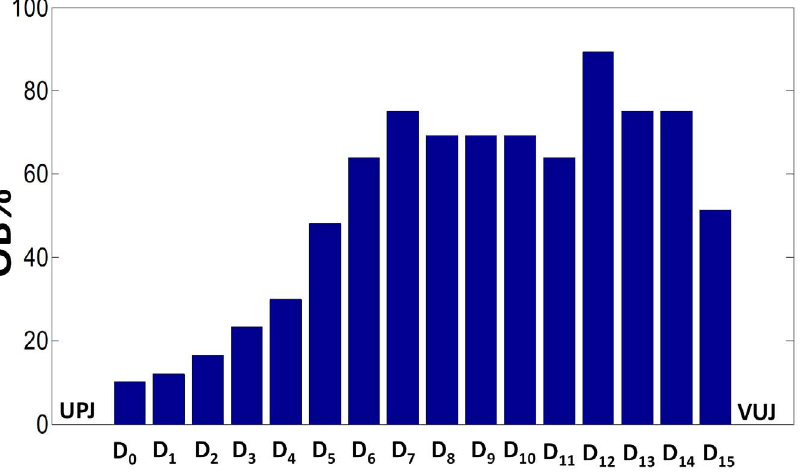
Figure 8. Severity of UM obstruction induced solely by stent insertion. Severity of obstruction (OB i %) calculated along the longitudinal coordinate of the UM ( D 0–15 , see Figure 4 for reference) introduced by the double-J stent only (absence of plastic sphere). For the calculations, Eq. 4 was considered. UPJ and VUJ indicate the urteropelvic and vesicureteric junctions, respectively.